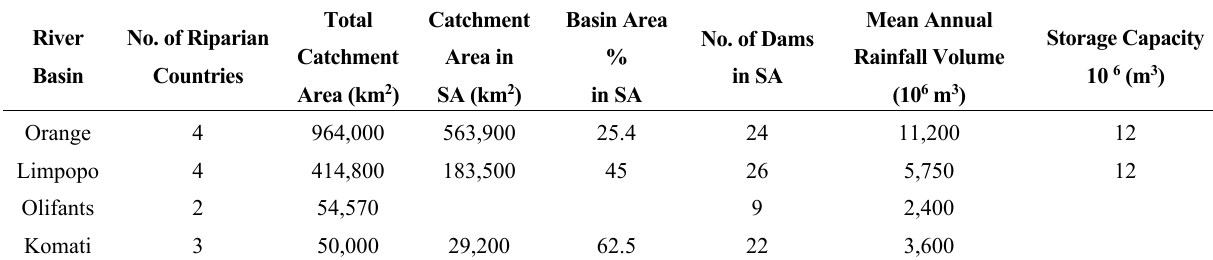
Table 1. Physical description of the most common river basins in South Africa. Source: